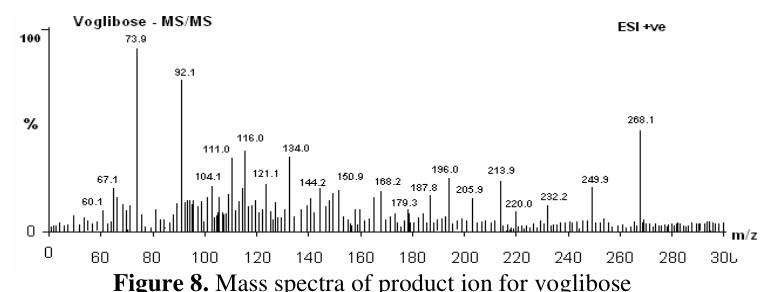
Figure 7. Mass spectra of parent ion for voglibose